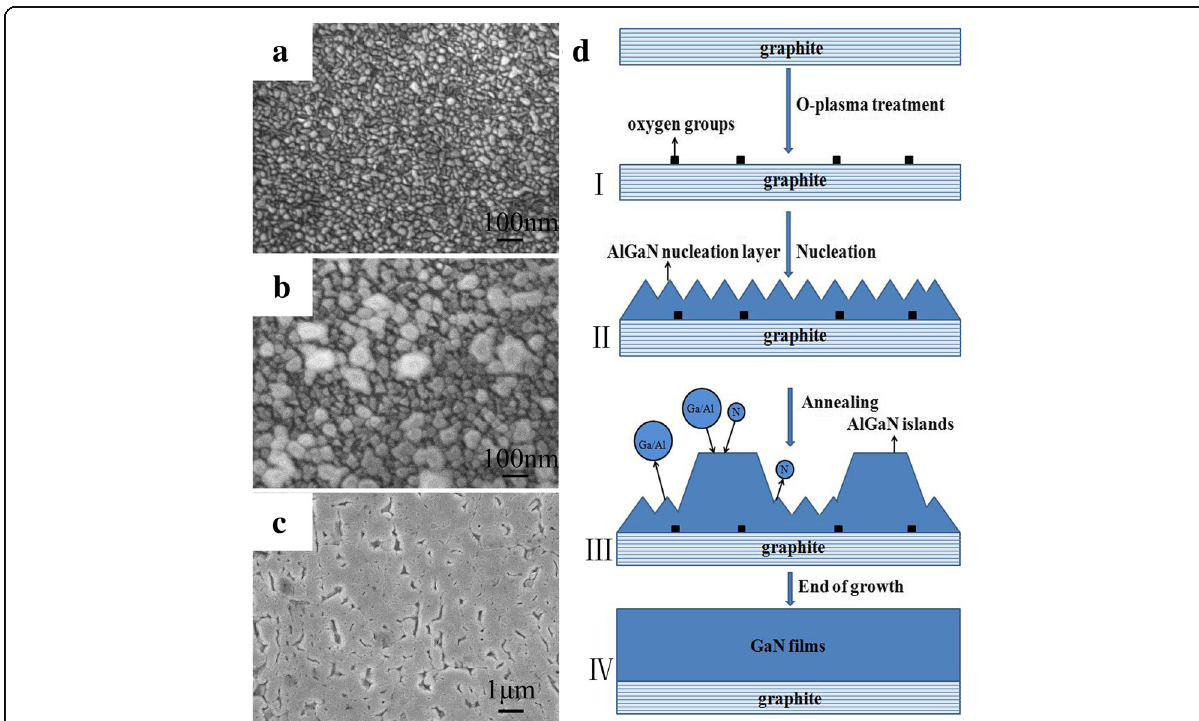
Fig. 5 a – c FE-SEM images of nucleation layers, annealed layers, and epitaxial layers, respectively. d Schematic of the corresponding growth mechanism of GaN films using AlGaN nucleation